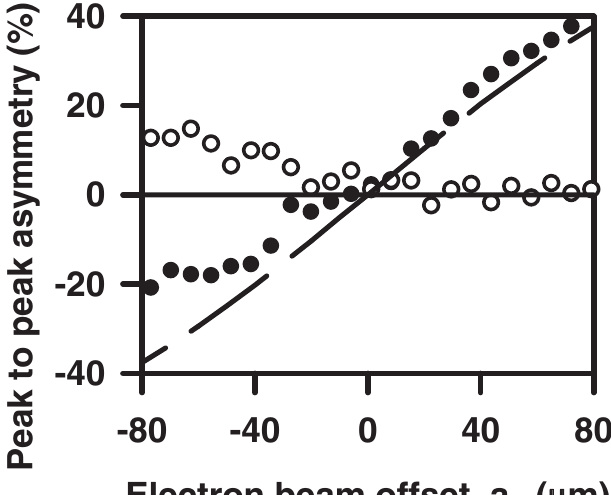
FIG. 24. Asymmetry of the ODR spatial distribution measured with (open circles) and without (black circles) the lens ( f (cid:5) 0 : 2 m ). The lines represent theoretically predicted asymmetry calculated for experimental conditions and for two geometries: solid line—with the lens; and dashed line—without the